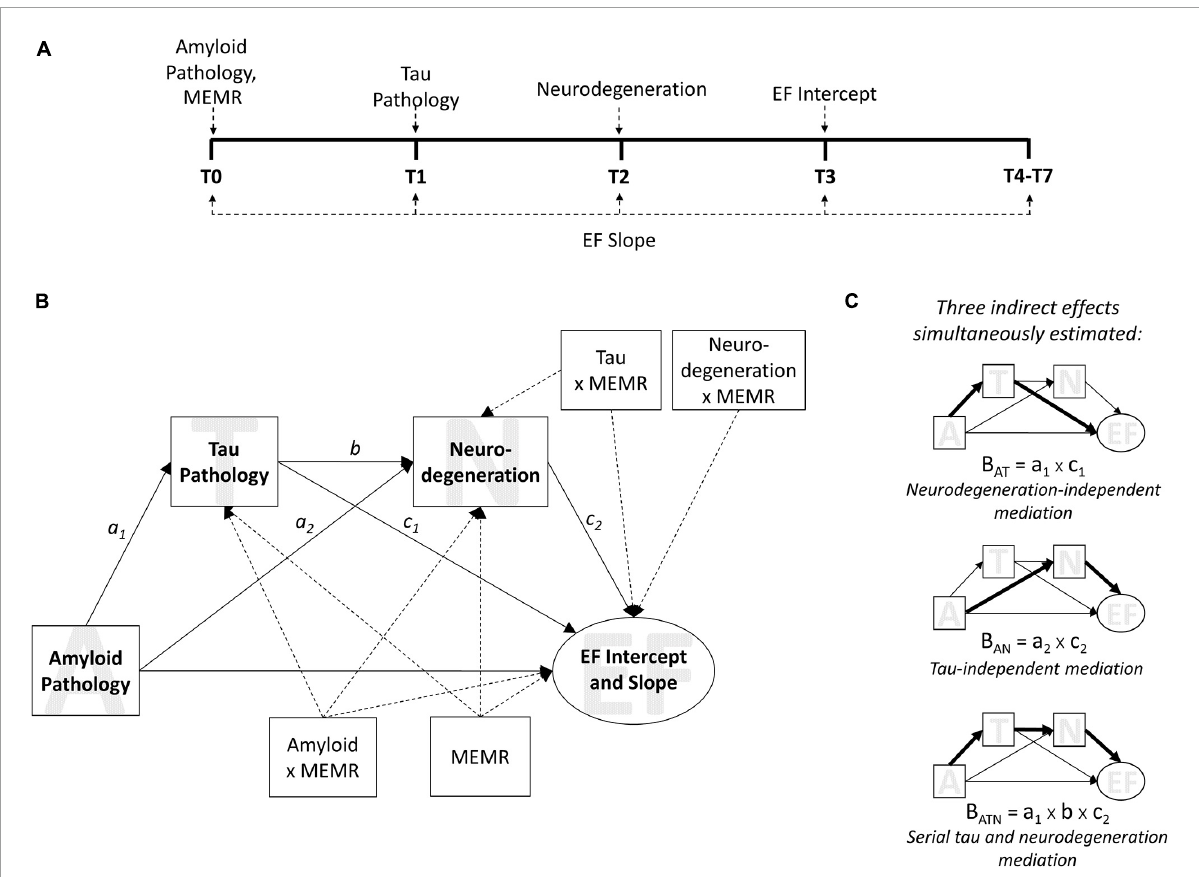
FIGURE1 The moderated sequential mediation model. Biomarkers used were the ratio of CSF β -amyloid 1 - 42 to β -amyloid 1 - 40 (A β 42 /A β 40 ) for amyloid pathology; plasma phosphorylated tau 181 (p-tau181) for tau pathology; and uptake of 18 F fluorodeoxyglucose tracer (FDG metabolism) in AD-specific regions of interest for neurodegeneration. Executive function (EF) was measured using ADNI’s composite measure of EF. MEMR denotes the residual reserve index. (A) the timeline of data collection for variables used in the sequential mediation model, from baseline (T0) through to the seventh annual follow-up (T7). (B) The moderated sequential mediation model used to test this study’s hypotheses. EF intercept and slope were latent growth factors; the intercept was estimated at T3, and the slope was estimated using all available time points (see Supplementary Figure 2 ). MEMR was entered as a moderator of all individual paths in the mediation component of the model. Dashed arrows are used for illustrative purposes, to signify paths that relate to moderation by MEMR; solid arrows relate to mediation relationships. Not